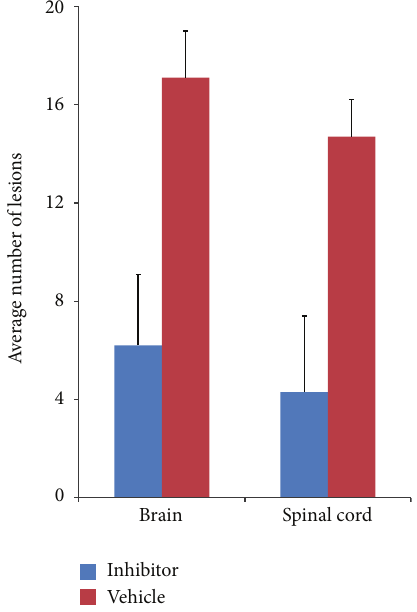
Figure 3: Morphometric analysis of infiltrated lesions in the brains and spinal cords of AX059-treated and vehicle-treated